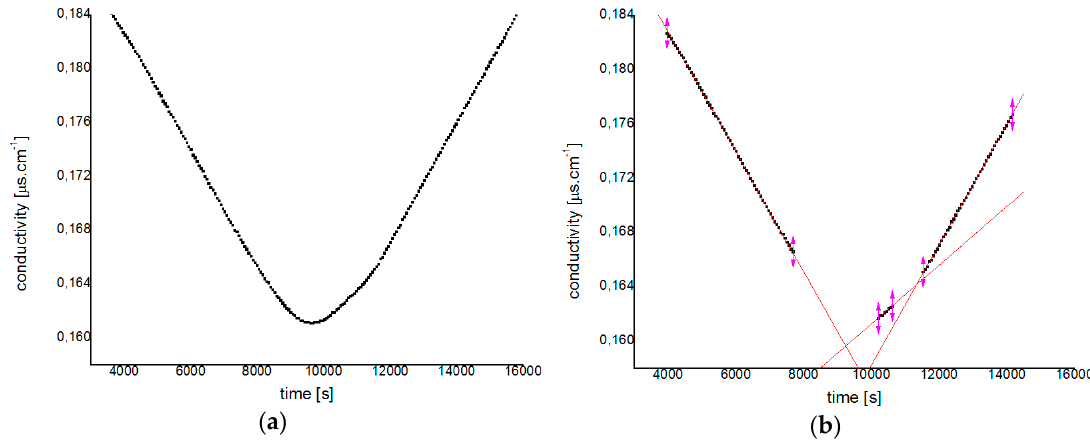
Figure 8. Conductometric titration for cellulose treated pulp with [bmim][HSO 4 ]: ( a ) conductivity data; ( b ) identification of three phases for titration.